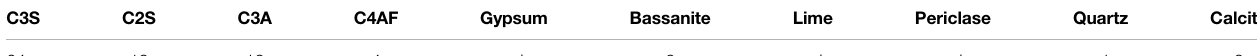
TABLE 2 | Mineralogical composition of the CEM I 42.5 R (XRD (Rietveld), wt%, n.d.: not detected). C3S C2S C3A C4AF